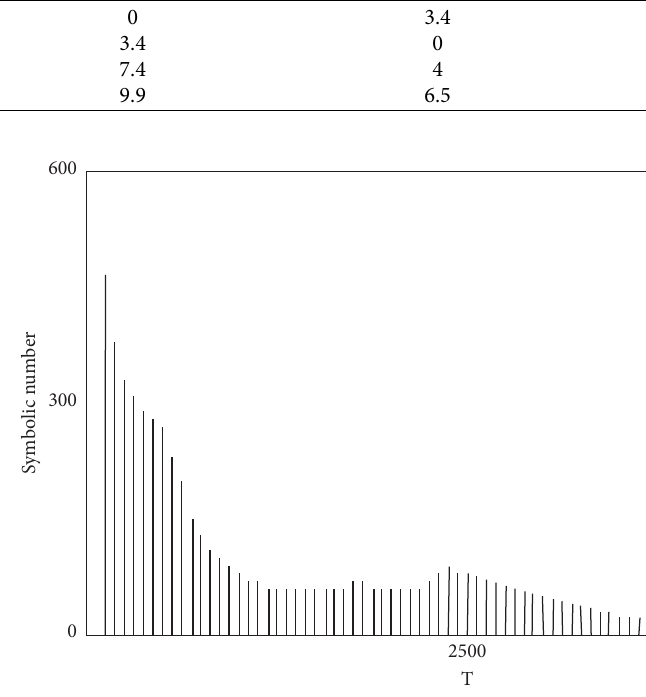
Figure 3: Te size of the character set produced by diferent t .